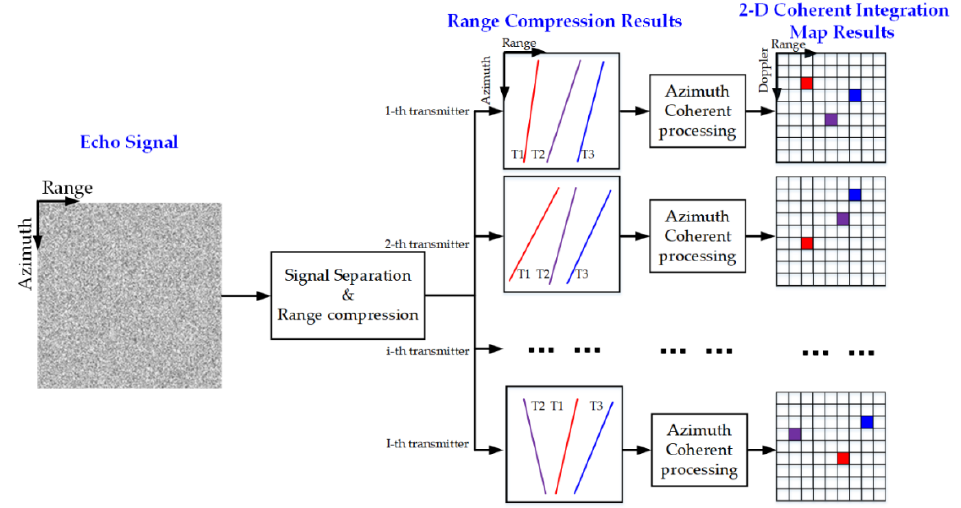
Figure 2. Diagrammatic sketch of 2-D coherent integration processing and map results in MsGBPR.